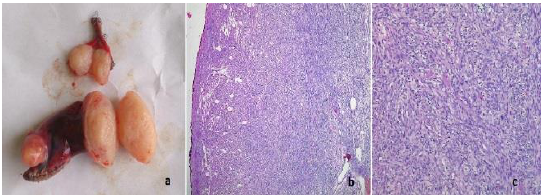
Figure 2: (a) Pulmonary nodule removed; (b and c) H&E: Low-grade spindle cell proliferation in the excised